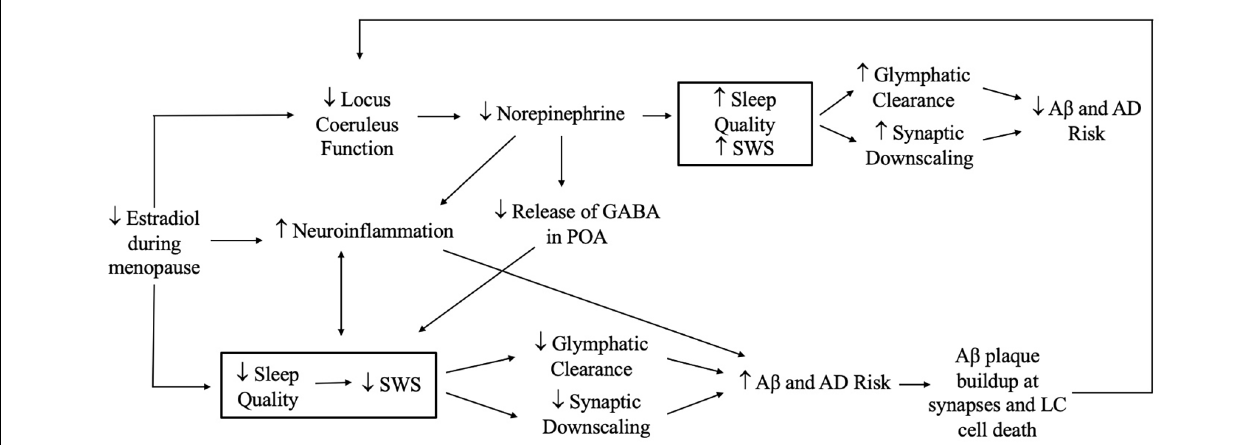
FIGURE 4 | Potential effects of estradiol reduction during menopause on sleep and Alzheimer’s disease (AD) risk. Reductions in estradiol during menopause can theoretically have both beneficial and adverse effects on sleep quality and SWS. Decreases in estradiol can decrease stimulation and function of the locus coeruleus and subsequent norepinephrine production, leading to increases in slow wave sleep (SWS) and enhancements in glymphatic clearance and synaptic downscaling that prevent amyloid beta (A β ) aggregation and AD risk. On the other hand, reductions in estradiol and norepinephrine could increase neuroinflammation, which promotes sleep disturbances and decreases SWS, leading to further neuroinflammation and forming a bidirectional link with sleep. Reductions in norepinephrine may decrease gamma-aminobutyric acid (GABA) in the preoptic area (POA), thereby increasing the risk of sleep disturbances. Theoretically, declines in estradiol could also degrade sleep quality, decreasing SWS. Subsequent buildup of A β could in turn lead to A β plaque formation, including at synapses of the LC, and result in LC cell death. The latter would further disrupt locus coeruleus function, creating a feedback loop. Note: not all plausible pathways are shown.